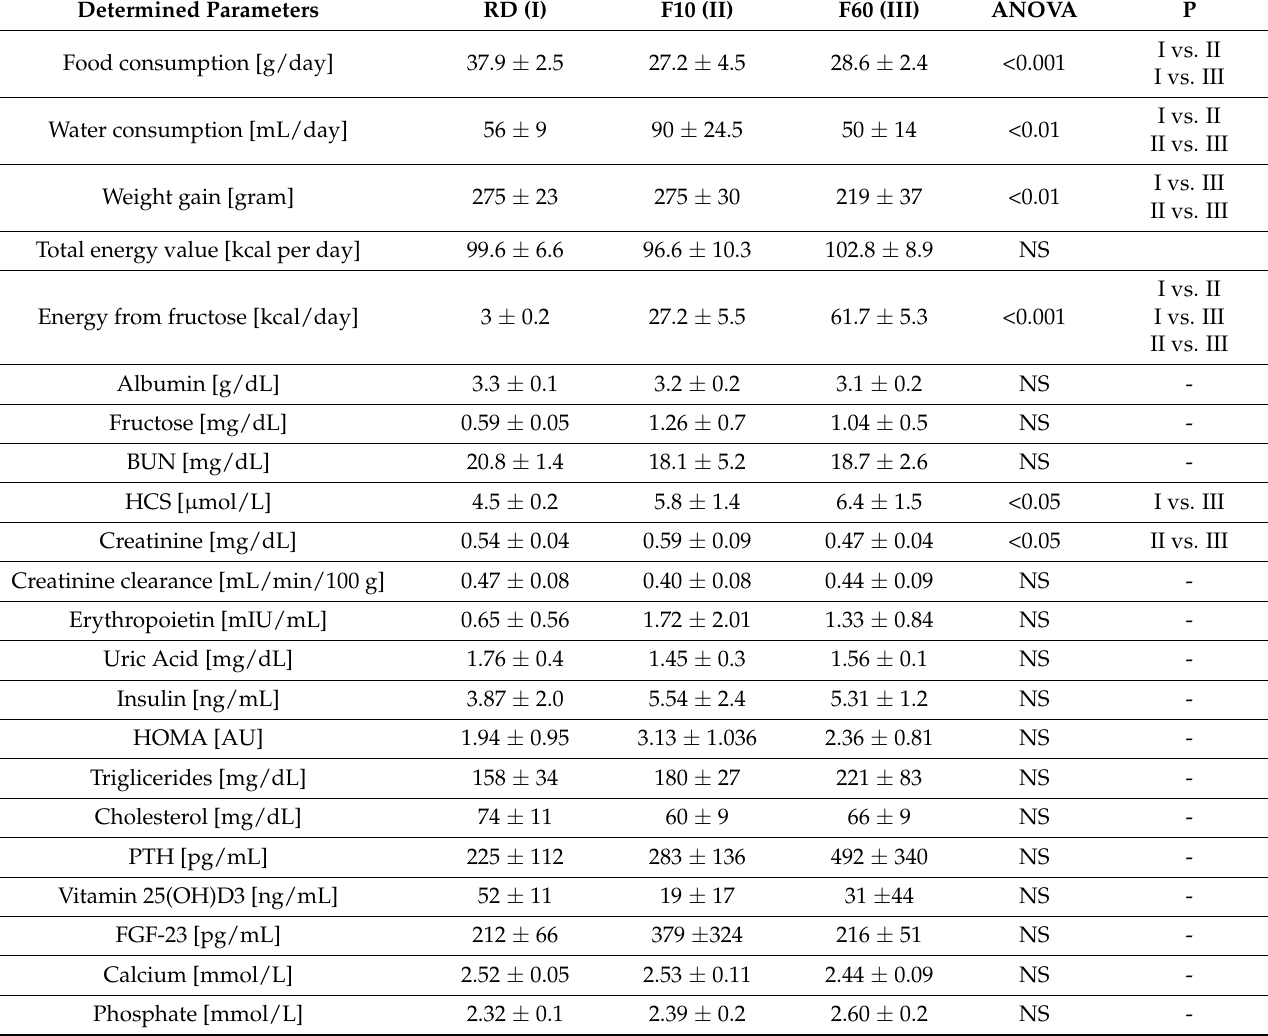
Table 1. Nutritional status and serum laboratory data of the animals after 8 weeks period on a regular diet (RD), a diet supplemented with 10% of fructose (F10) and 60% of fructose